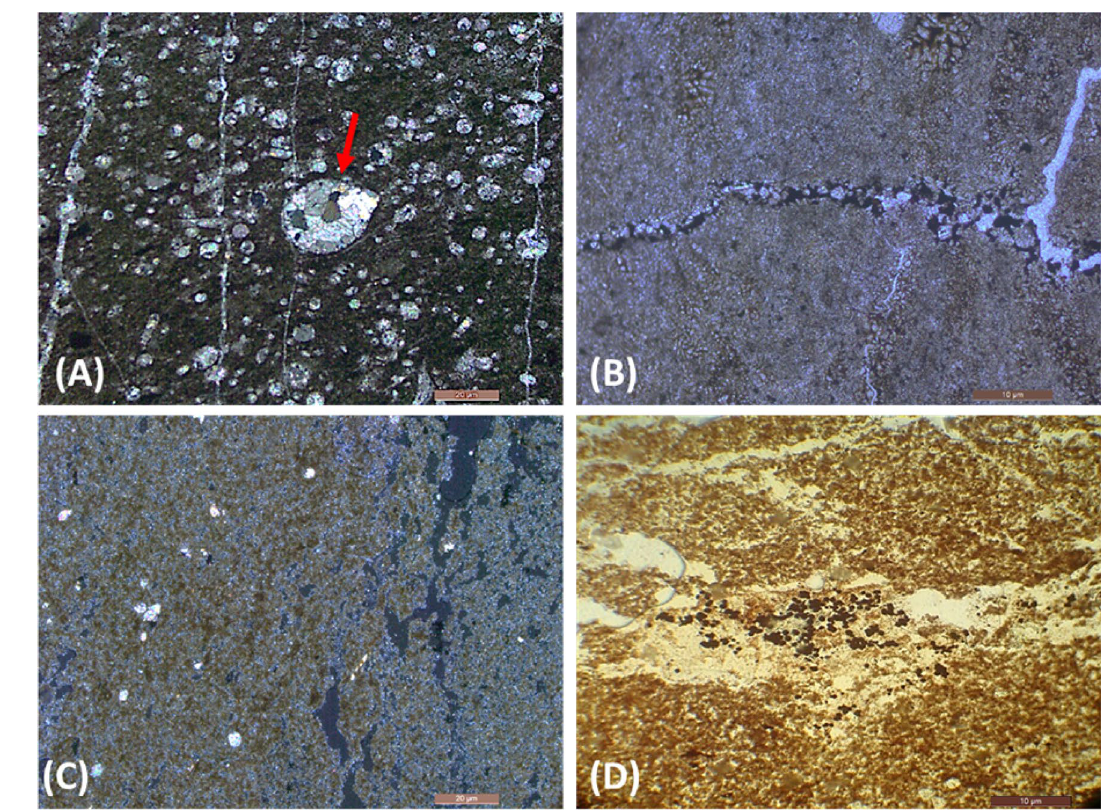
Fig. 9 a Moldic Porosity (arrow), a type of secondary porosity filled with sparry calcite (granular cement). Br-47, X.N. b Fractured Poros- ity, filled with pyrite and/or organic matter in micritic matrix. Bk-4,